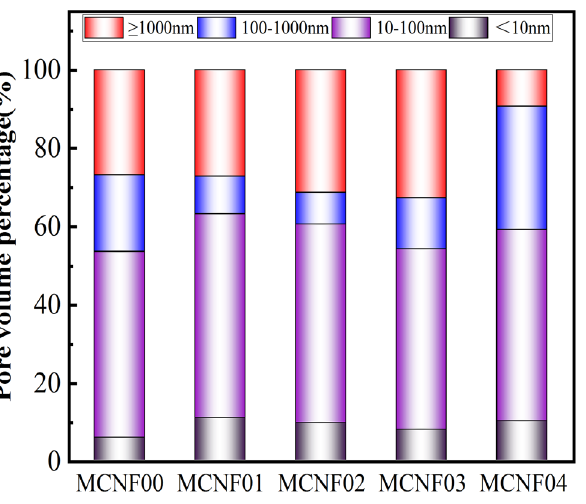
Figure 11. Pore distribution of MCNF